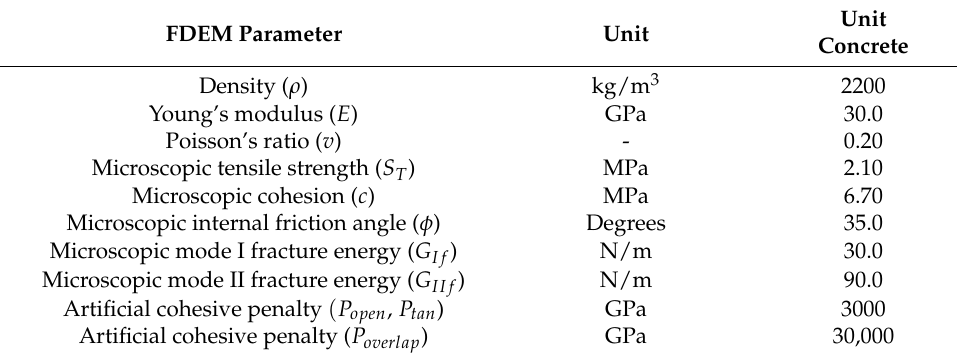
Table 2. Calibrated input parameters for the FDEM simulation of fracture behaviors in the concrete structures [33].